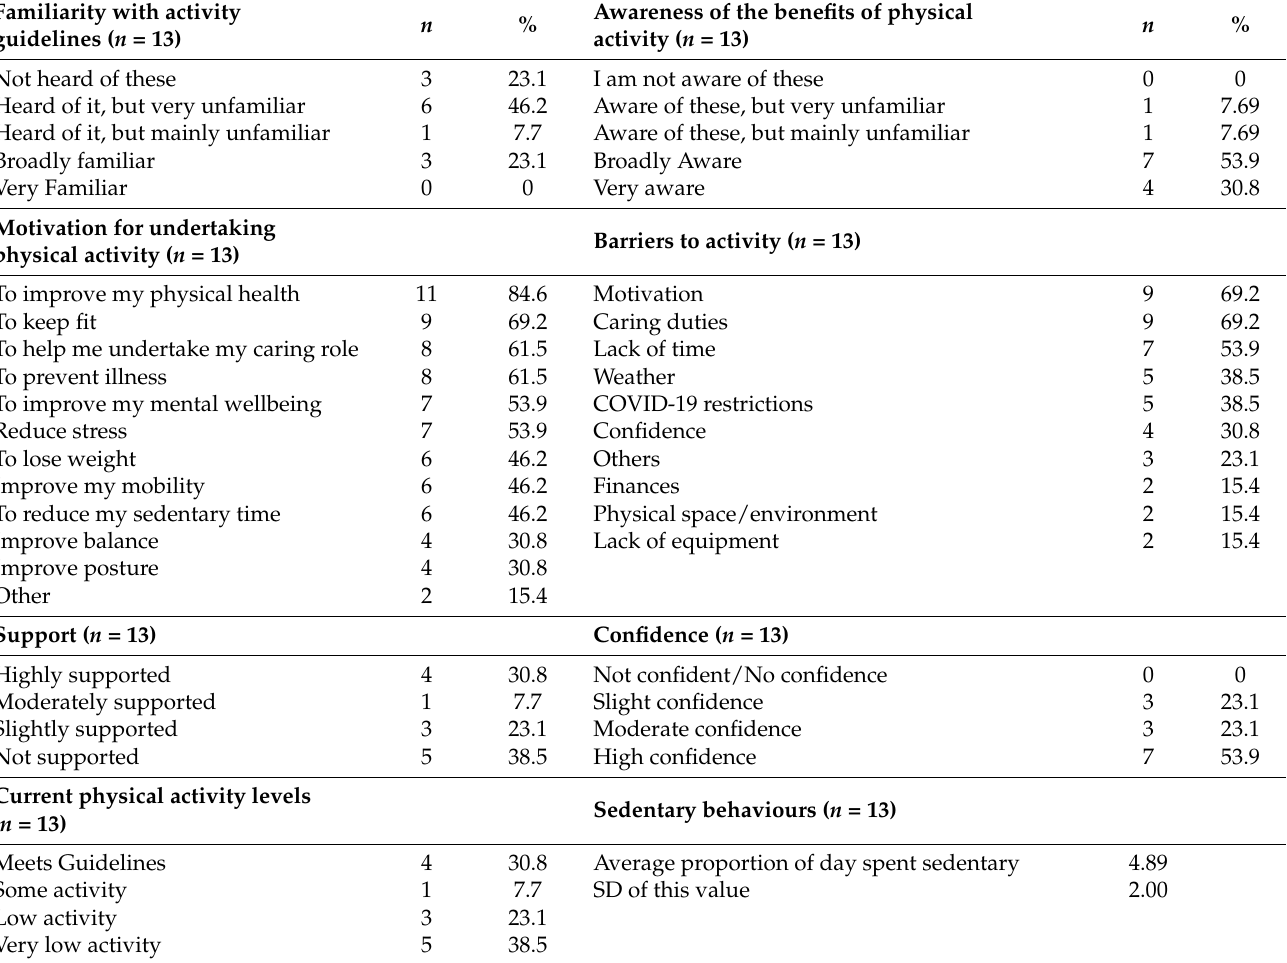
Table 3. Physical activity levels and views of participants at follow